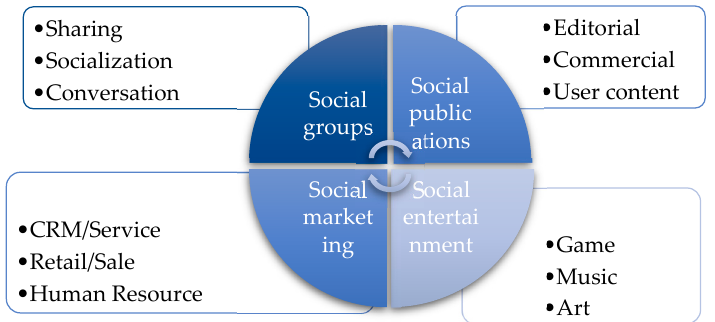
Figure 1. Social media marketing categories.